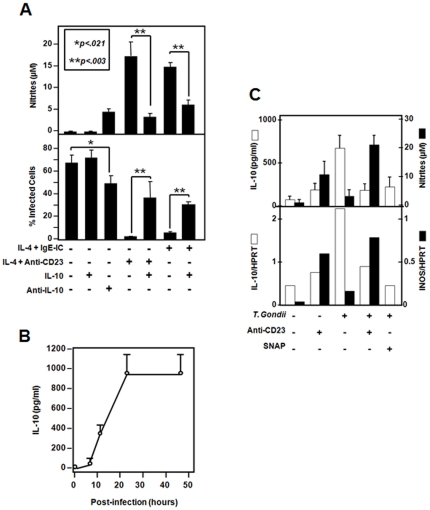
Inhibition of IgE-IC-mediated toxoplasmacidal activity of human macrophages by endogenous and exogenous IL-10.(A) Simultaneous addition of recombinant IL-10 (10 ng/ml) to CD23-engaged macrophages significantly decreased their ability to eliminate T. gondii. Addition of neutralizing anti-IL-10 (20 µg/ml) McAb increased cell resistance to infection in the absence of CD23 engagement. Results show mean±SD from 3 distinct MDM preparations following 72 h incubation, each done in duplicates. (B) Infection with T. gondii induces IL-10 generation by human macrophages. Results show mean±SD from two distinct MDM preparations, each done in duplicates. (C) Infected or uninfected cells were incubated with anti-CD23 or chemical NO (SNAP) and were collected 24 h later for iNOS- and IL-10-mRNA quantification and cell supernatants were harvested (72 h) to assess the levels of nitrites and IL-10. CD23 engagement reduced T. gondii-mediated IL-10 increase at both mRNA and protein levels and was inversely correlated with iNOS expression by infected human macrophages. Chemical NO (SNAP) also reduced the IL-10 expression from infected macrophages. Results show mRNA quantification from one representative macrophage preparation, out of two and mean±SD from 2 distinct MDM preparations following 72 h incubation for the quantification of mediators, each done in duplicates.